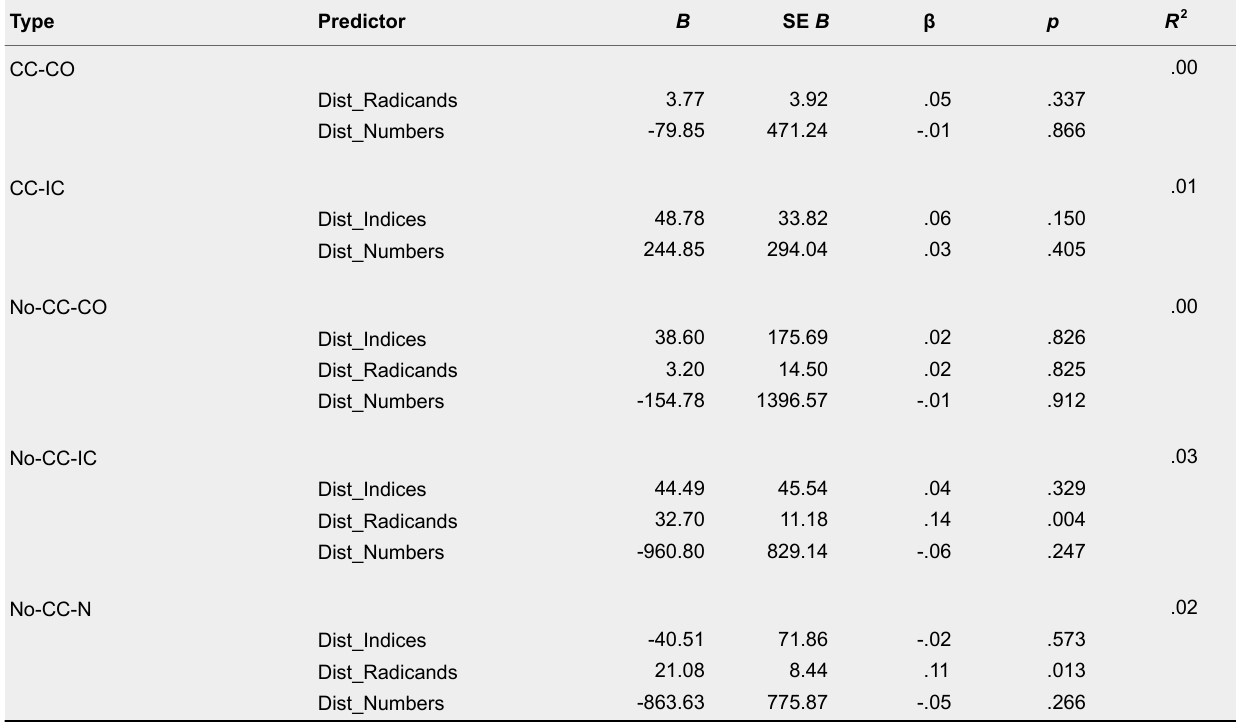
Results of the Multiple Linear Regression Analysis With Numerical Distances as Predictors and Response Times on Correctly Solved Items as the Depending Variable, for Each Type of